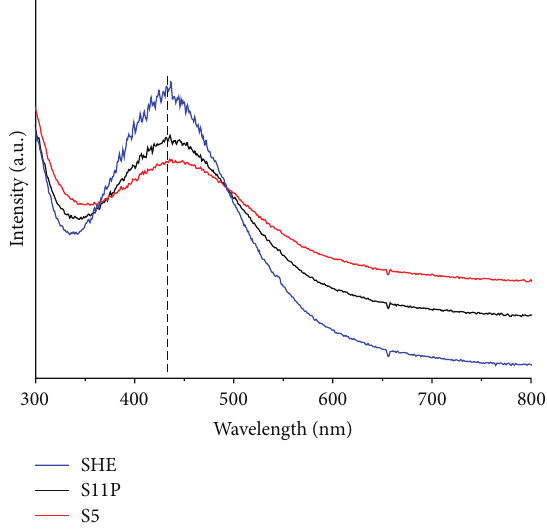
Figure2:UV-visspectroscopyabsorptionspectraofsilvernanopar- ticles synthesized by different isolates (SHE, S11P, and S5